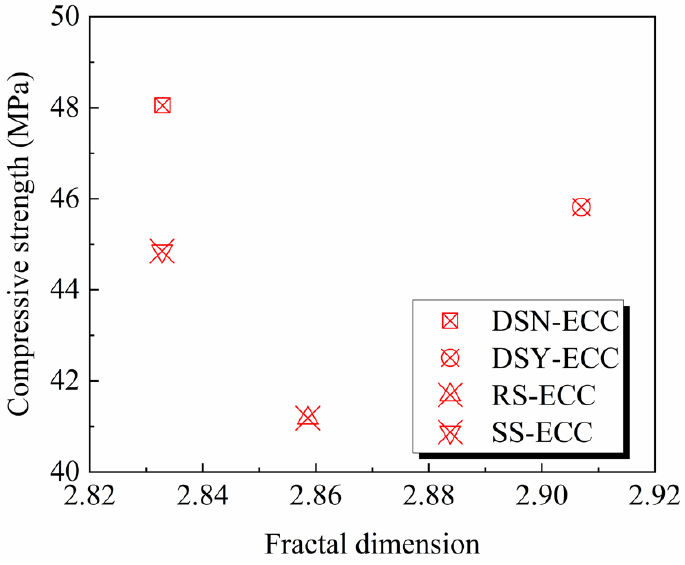
Figure 11. The relationship between fractal dimension and compressive strength.